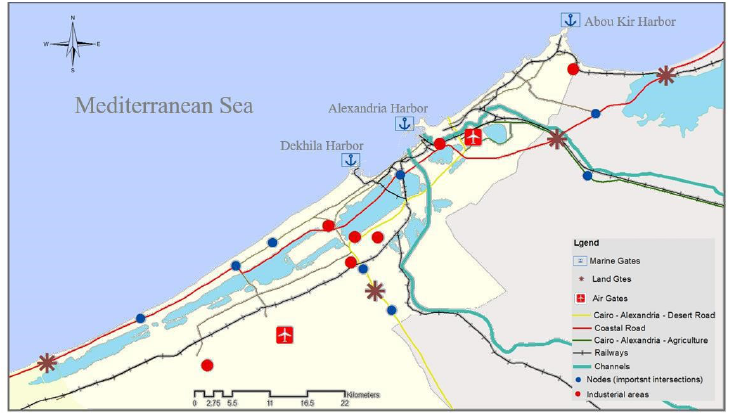
Figure 2. Alexandria high ways and important